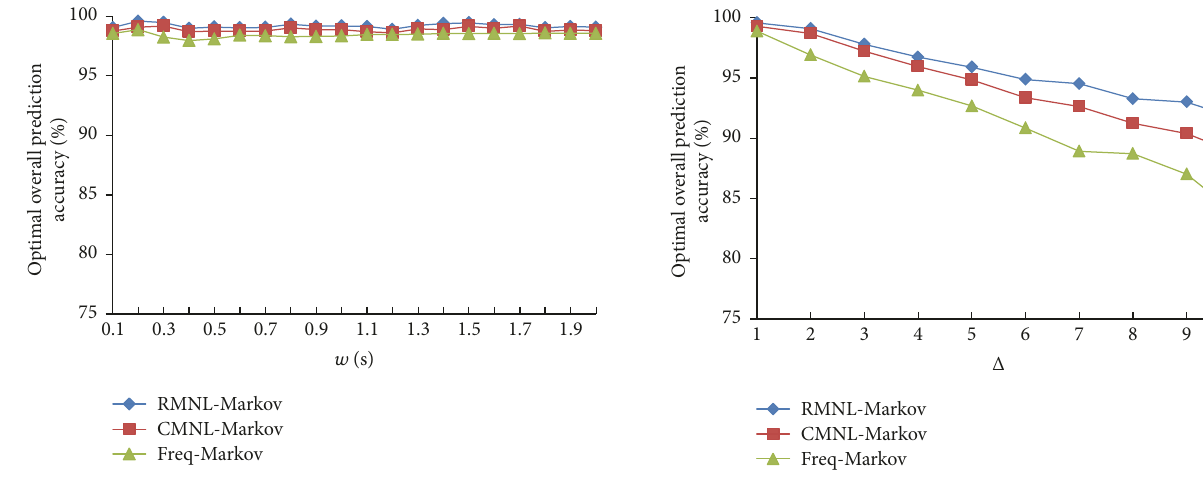
Figure 6: Prediction accuracy and time window length.